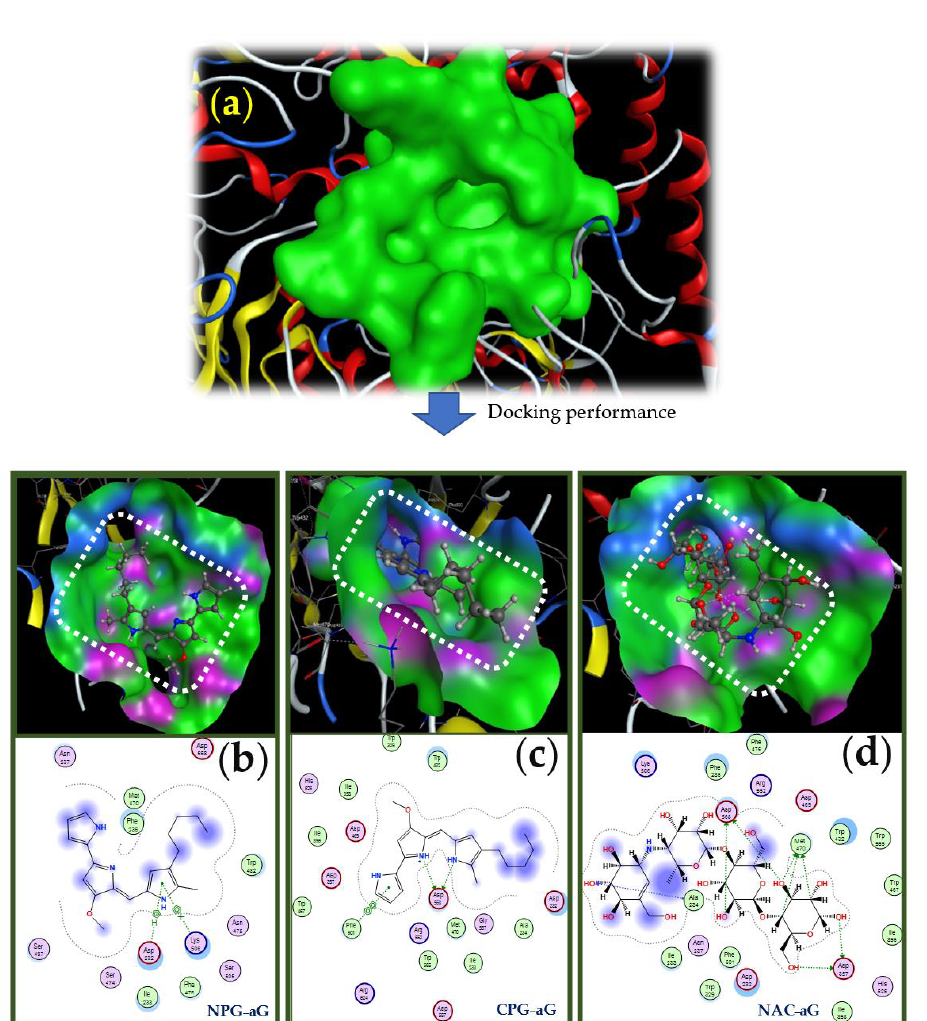
Figure 8. The docking study of prodigiosin and acarbose with α-glucosidase enzyme. The 3-D structure of the binding site on α-glucosidase ( a ). The interactions and binding of the ligands neutral - PG, cation-PG, and neutral - AC with the α-glucosidase enzyme are labeled as NPG-aG ( b ), CPG-aG ( c ), and NAC-aG ( d